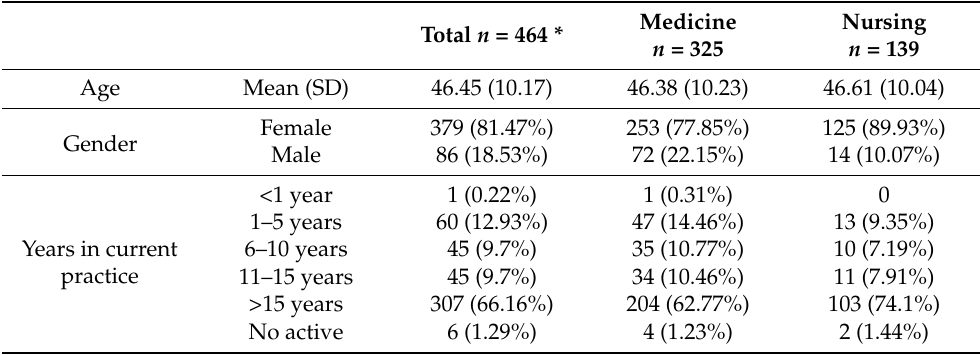
Table 1. Sociodemographic characteristics and